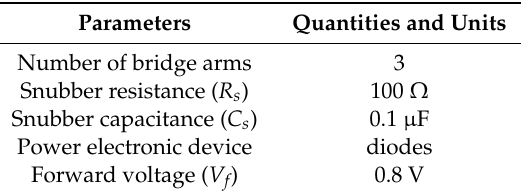
Table 3. Parameters of rectifier.